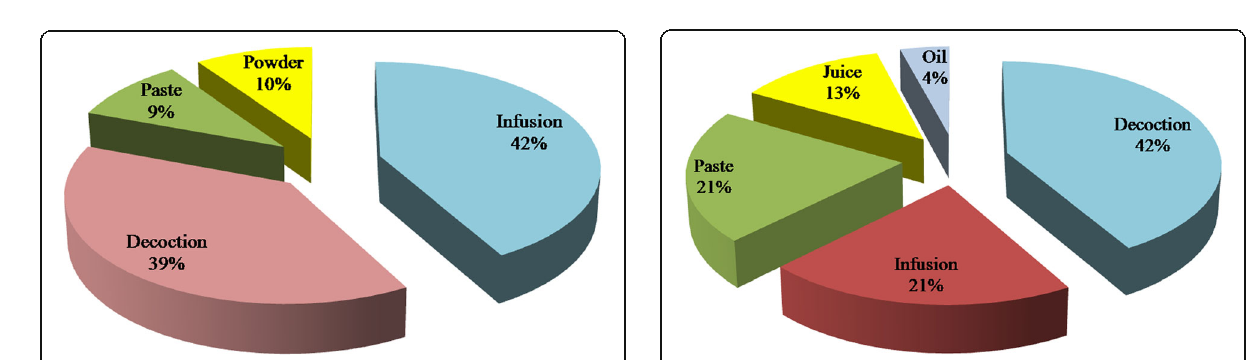
Fig. 3 Frequency of herbal remedies preparation methods which used for the treatment of infertility in